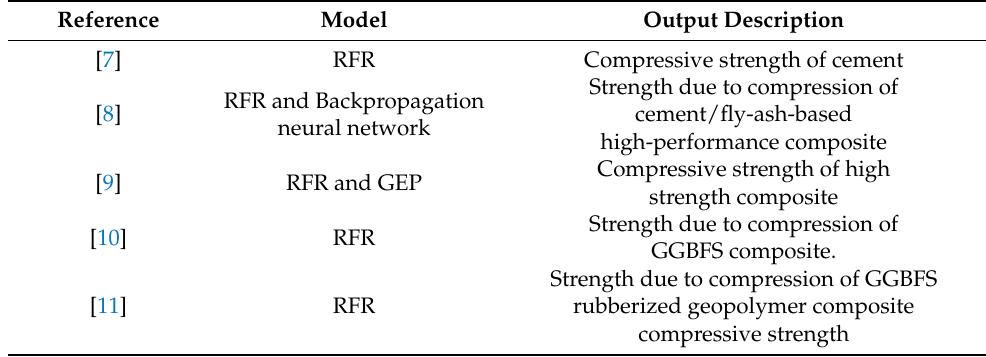
Table 1. List of RFR-related literature